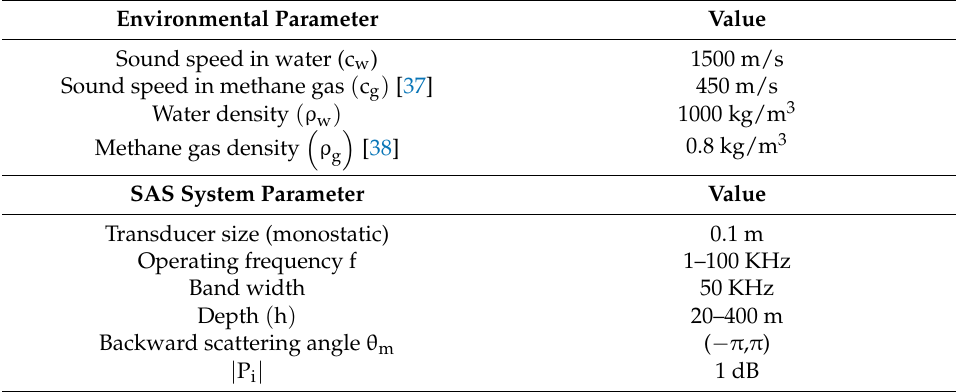
Table 1. Simulation